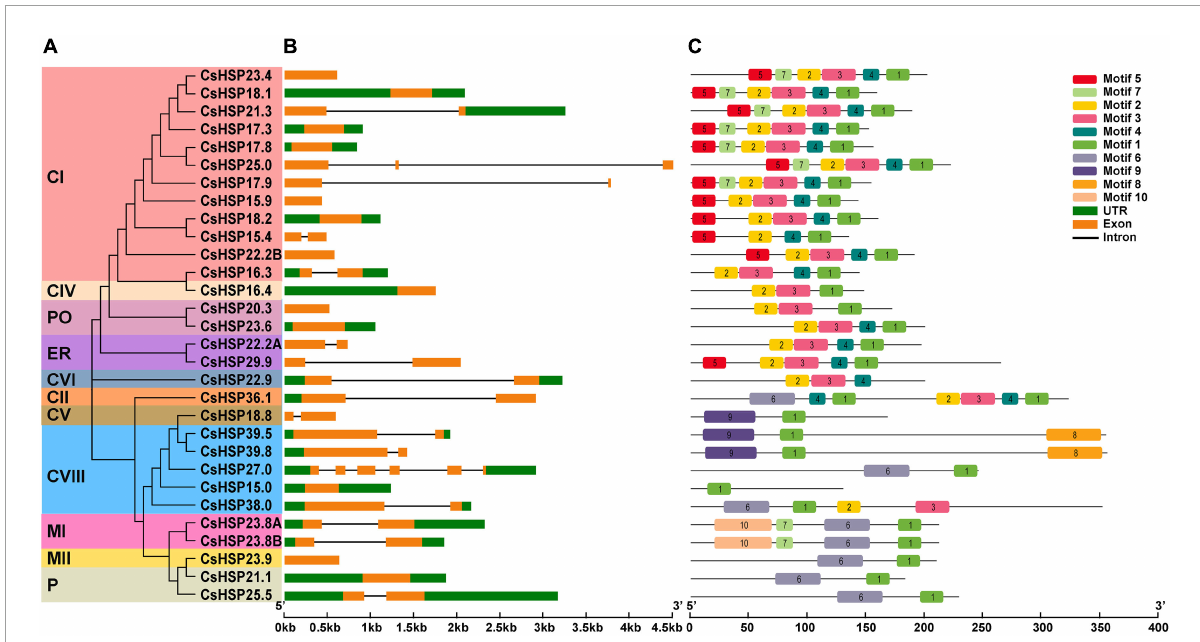
FIGURE4 Gene structure and conserved protein motifs of HSP20 in cucumber. (A) The NJ phylogenetic tree of CsHSP20. The different colors represent the different subgroups. (B) Gene structure of CsHSP20 genes. The untranslated regions, introns, and exons are indicated by green boxes, golden boxes, and solid gray lines, respectively. The scale at the bottom is in kp. (C) Conserved motifs in CsHSP20 proteins. Boxes of different colors represent different motifs. Details of each motif are shown in Supplementary Table 2 .